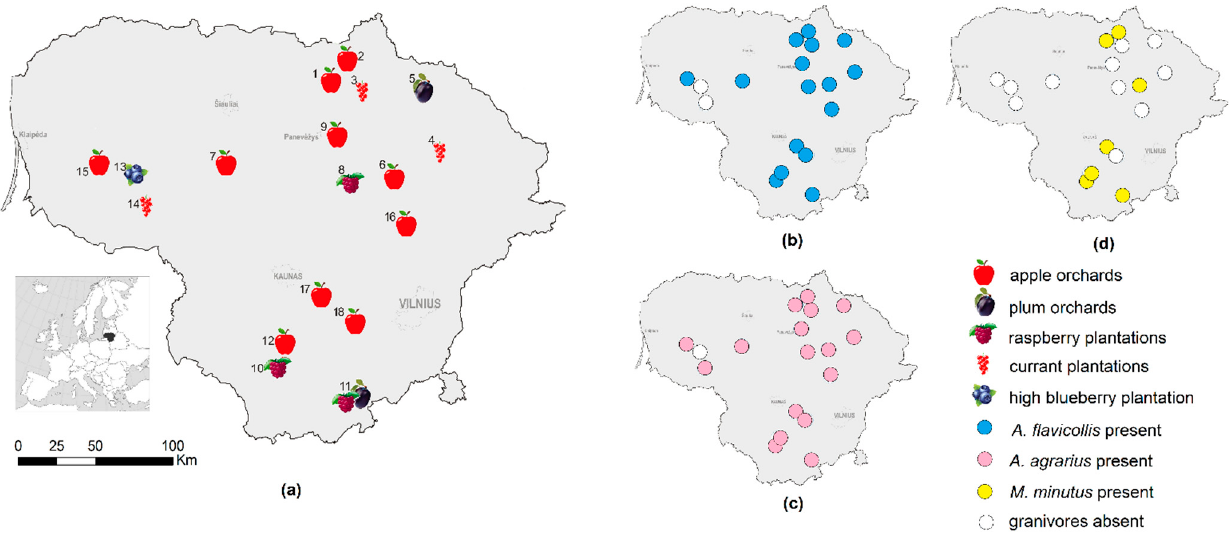
Figure 1. Commercial fruit orchards and berry plantations. ( a ) At the trapping sites in Lithuania, 2018–2020. The distribution of the granivorous species: ( b ) A. flavicollis , ( c ) A. agrarius , and ( d ) M. minutus .